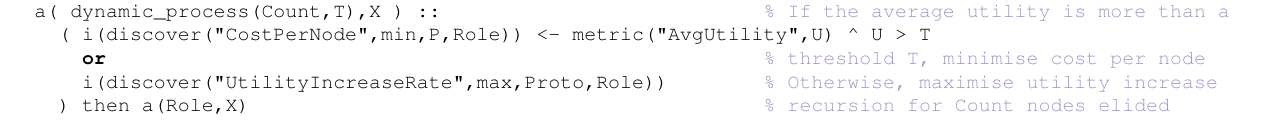
Listing 2. Example dynamic protocol, used to choose roles The metric predicate retrieves the current value of a particular metric. In this particular case, metric (” AvgUtility ” , U ) reports on user satisfaction, which is then fed into